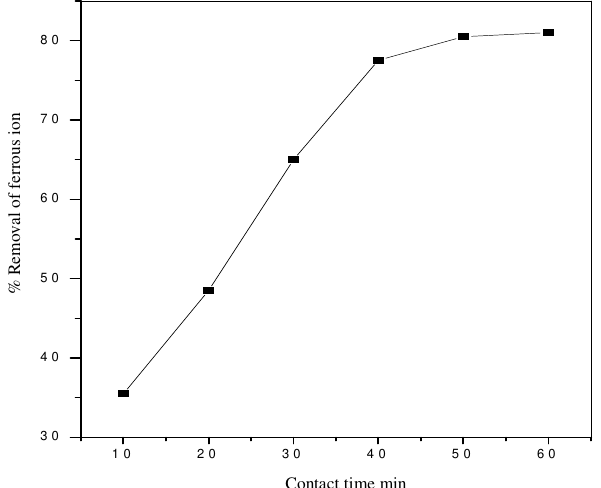
Figure 1. Effect contact time on the adsorption ferrous ion onto ZDC [M] = 15 mg/L; Adsorbent dose = 25 mg/50 mL: temp = 30 o